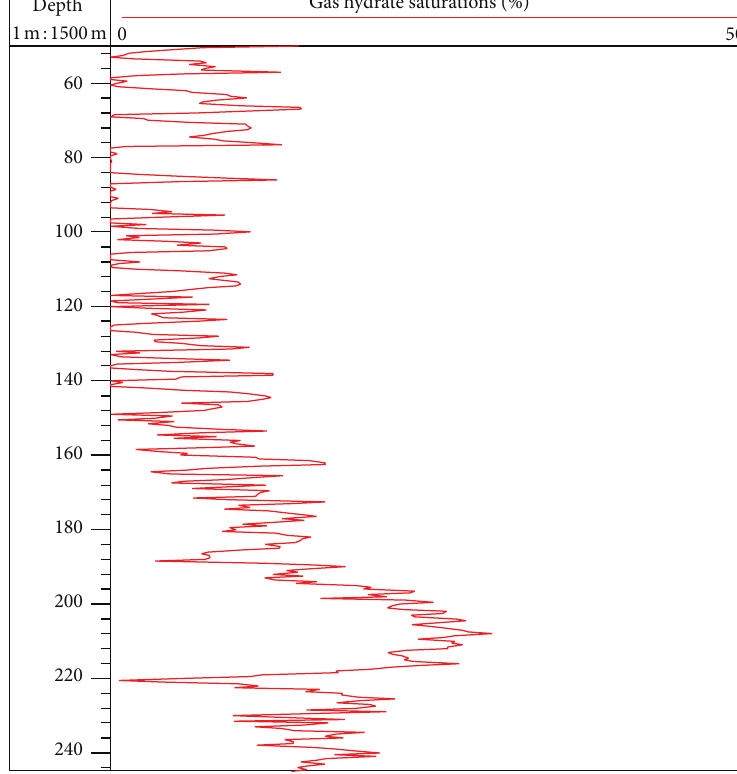
Figure 7: Estimation of gas hydrate saturation at site